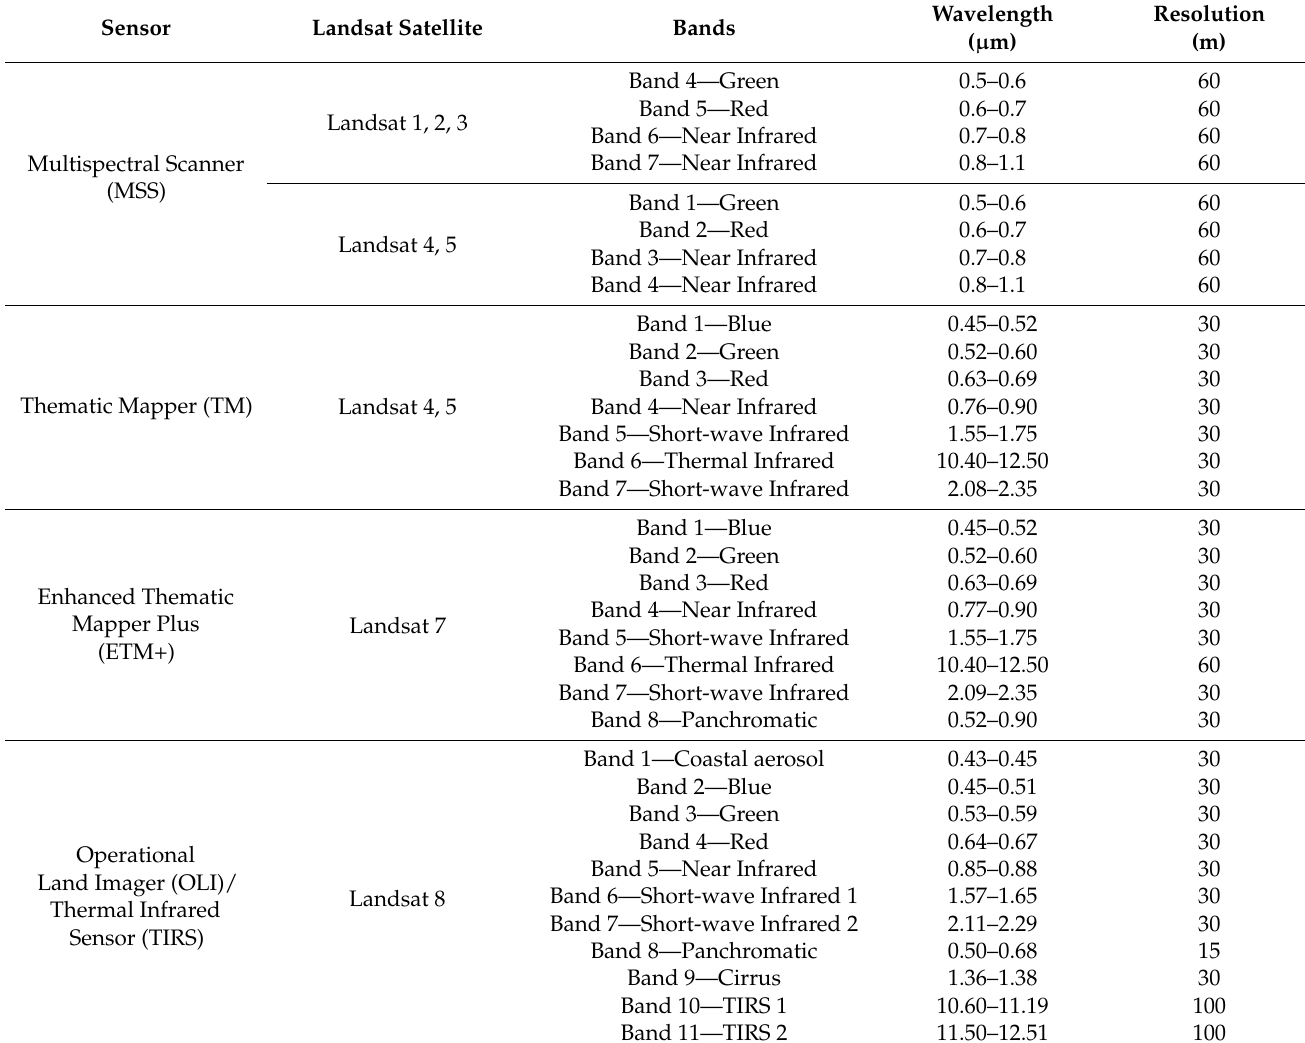
Table 2. Specification of Landsat satellite sensor, bands, wavelength and resolution.